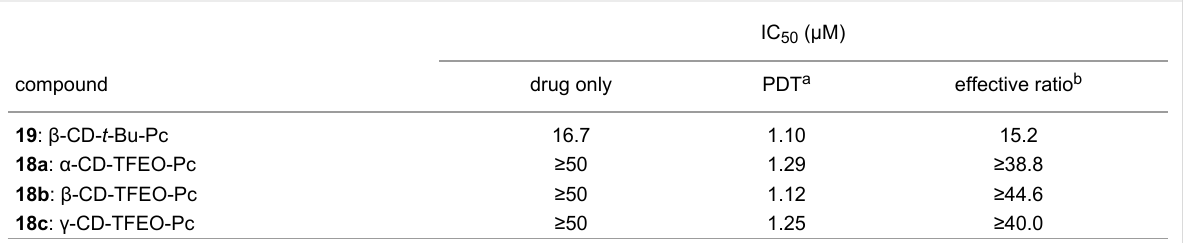
Table 2: Comparison of IC 50 values with laser PDT among phthalocyanine conjugated with cyclodextrin against B16-F10.